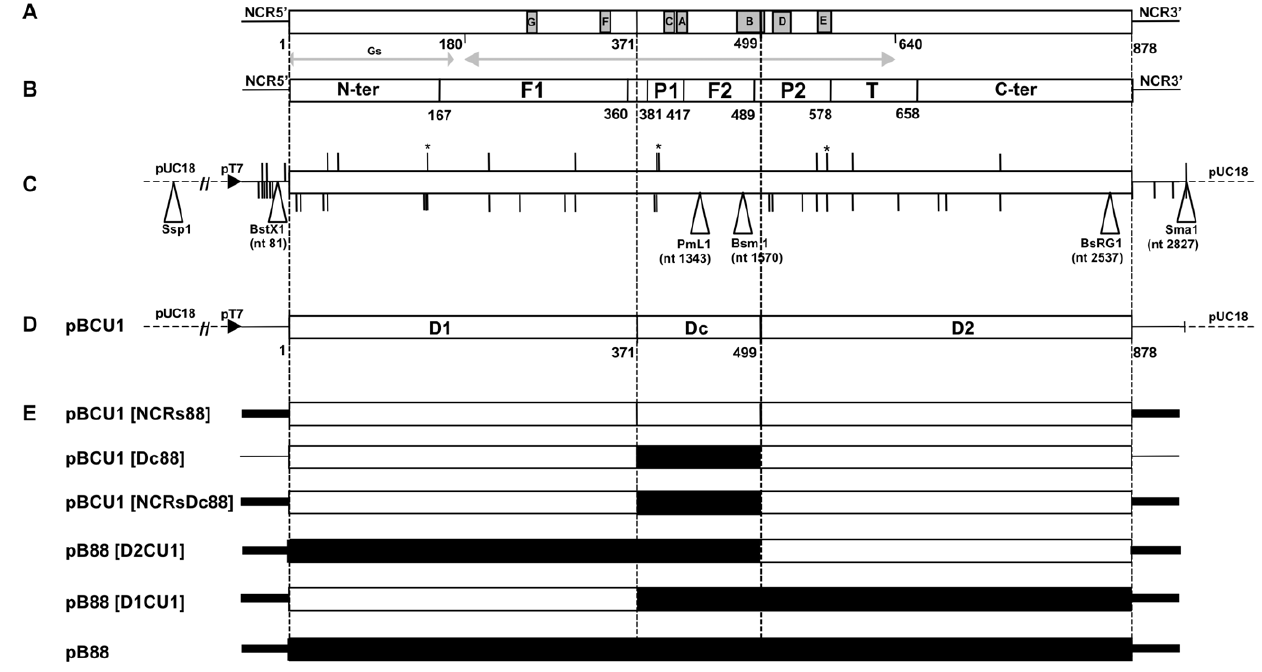
Figure 1. Organisation of IBDV segment B and construction of mosaic B segments derived from pB88 and pBCU1. A ) Position of the motifs involved in the biological activity of IBDV RdRp. The first double arrow (aa 1 to 175) shows the possible region where the self-guanylylation site (Gs) of IBDV RdRp is predicted to be positioned [26]. The 7 others motifs (G, F, C, A, B, D and E) are present in the central domain of the polymerase and are suggested to be involved in the nucleotide recognition and binding (motif A, B and F), phosphoryl transfer (motif A and C), control of metal dependence (motif C), structural integrity of the palm (motif D), priming nucleotide binding and proper positioning of the ‘‘Thumb’’ relative to the ‘‘Palm’’ (motif E), and template binding (motif B, F and G) (see text for references). The second double arrow indicates the domain of VP1 interacting with VP3 [55]. Finally, aa 371 to 499 have been defined as a region with alternating b layers and a helixes corresponding to the Palm 1 and Finger 2 region delimiting the catalytic domain. B ) The tri-dimensional structure of the IBDV RdRp recently solved allowed to determine that the polypeptide chain can be divided into three domains: i) an N-terminal domain (residues 1–167) surrounding ii) the central polymerase domain (residues 168–658) which contains the ‘‘fingers’’ (F1 and F2), ‘‘palm’’ (P1 and P2) and ‘‘thumb’’ (T) subdomains and iii) a C-terminal domain (residues 659–878) [21,22]. C ) Segment B of 88180 cloned into the pUC18 plasmid under the control of the T7 promotor (horizontal black triangle). The position of nts (NCRs) or aa (coding region) that differentiate 88180 from pBCU1 or D6948 are indicated by short black vertical bars appearing below or above the plasmid, respectively. Asterisks identify conserved aa typical of vvIBDV [39] that are modified in 88180. White vertical triangles indicate the position of unique and conserved enzymes restrictions sites used for the construction of pBCU1/pB88 mosaic plasmids. D ) The two regions of IBDV VP1 (D1 and D2) surrounding the catalytic domain (DC) considered for the construction of mosaic segment B, together with the aa position of their boundaries. E ) The constructed mosaic B segments. Black and opened areas represent genome regions derived from pB88 and pBCU1, respectively. See in text the method of construction.